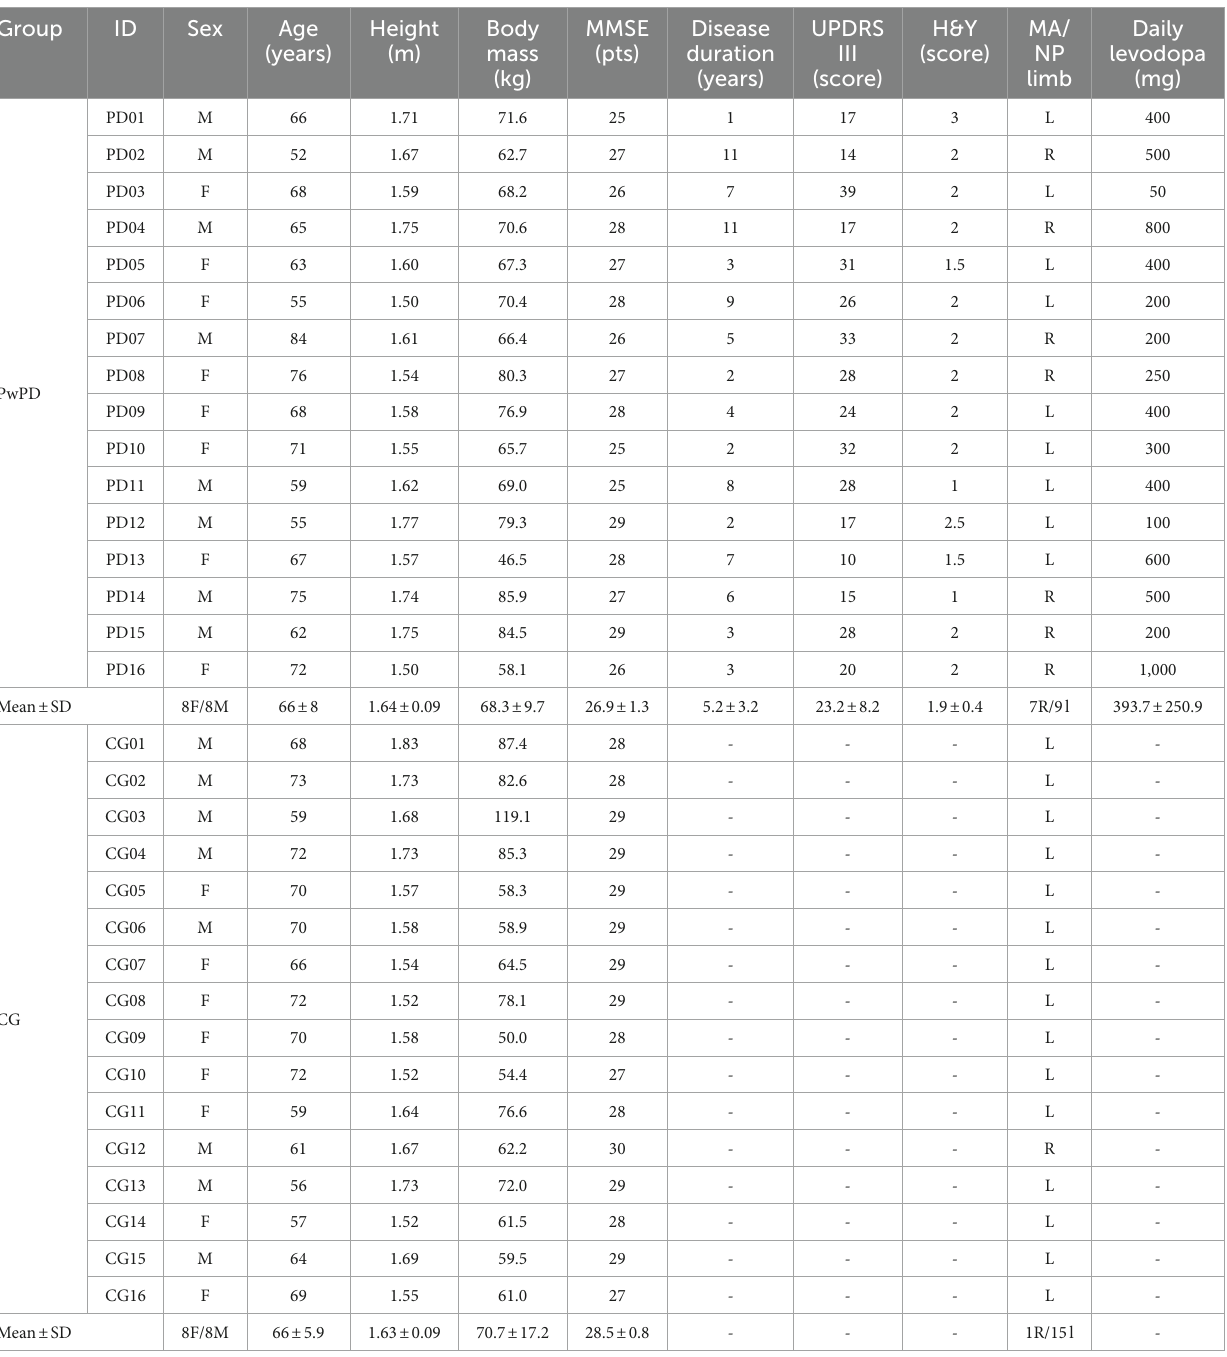
TABLE 1 Demographic and clinical characteristics of the participants.